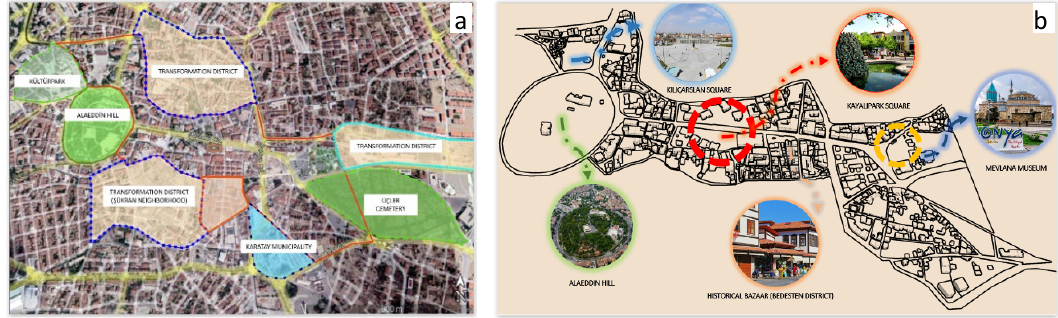
Figure 8 Boundaries of the research area (a), Important nodes in the research area (b) (Ünal, 2022)